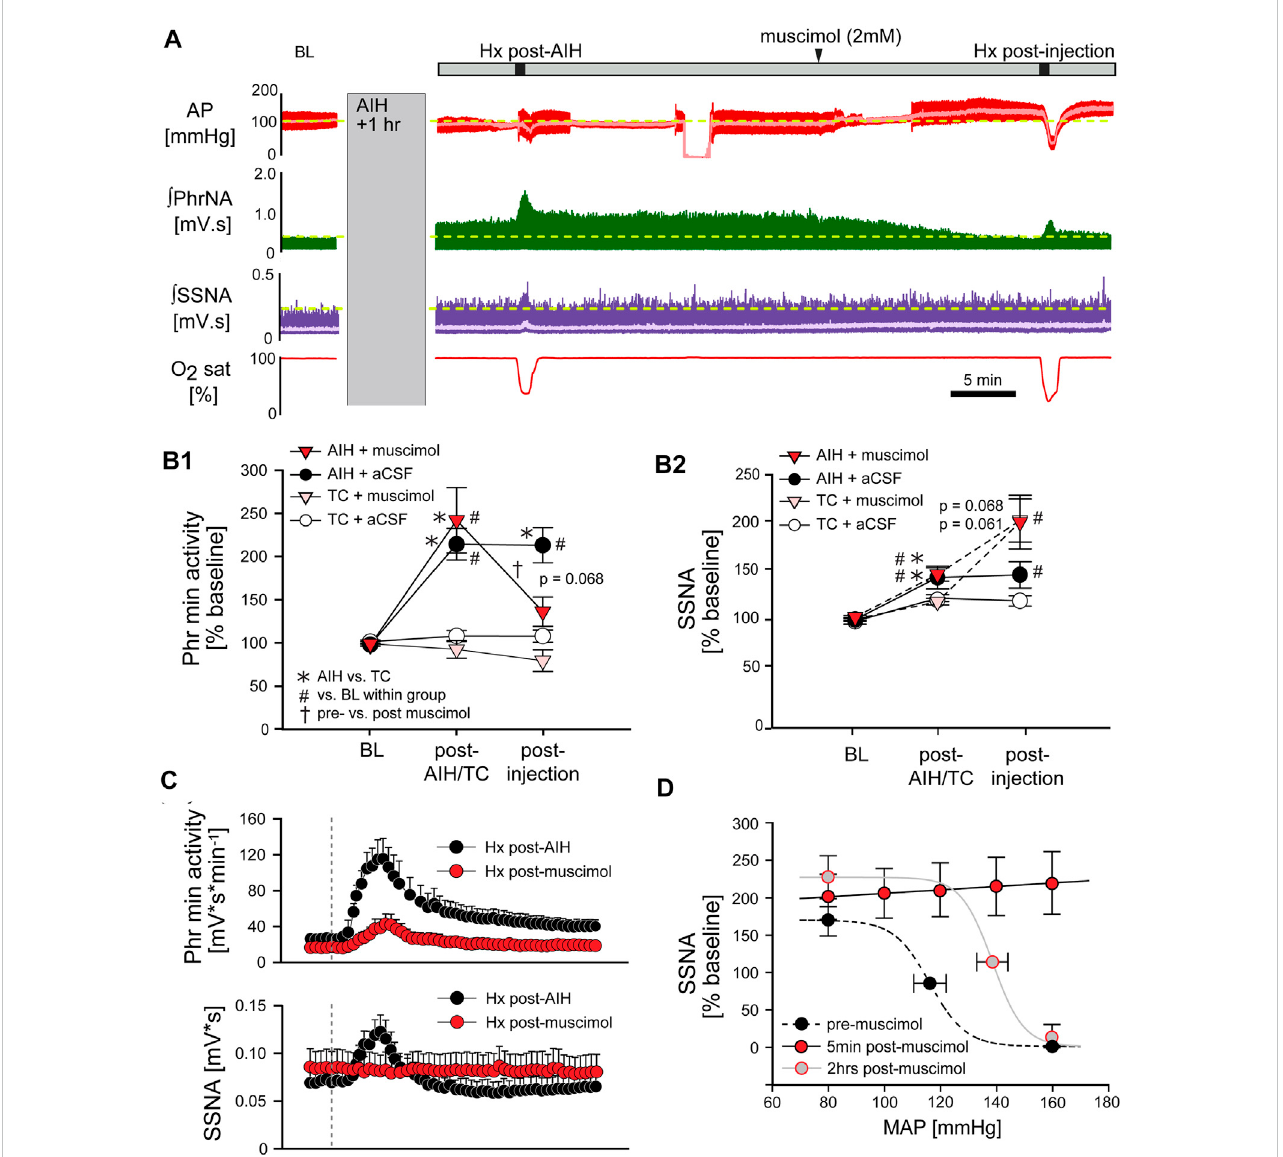
FIGURE 8 InhibitionofnTSactivityfollowingAIHreversespLTF. (A) ExamplerecordingofAP(red,MAPsuperimposedinlightred), ʃ PhrNA(green)and ʃ SSNA(purple, mean in light purple) at baseline (BL), LTF (1 h after AIH), during Hx post-AIH, in response to bilateral nTS injection of muscimol after LTF development and during Hx post-injection of muscimol. (B) Phr min activity (B1) or SSNA (B2) during periods in enriched O 2 in animals injected with muscimol or aCSF after either AIH or TC. Following AIH, Phr min activity and SSNA were signi fi cantly elevated. Subsequent nTS inhibition with muscimol (AIH + muscimol; red triangles, n = 9) reduced Phr min activity whereas control injections of aCSF (AIH + aCSF; black circles, n = 5) had no signi fi cant effect. In TC rats, injections of either muscimol (TC + muscimol; pink triangles, n = 5) or aCSF (TC + aCSF; white circles, n = 3) did not alter Phr min activity. nTS muscimol signi fi cantly increasedSSNAtosimilarlevelsfollowingeitherAIHorTC.Two-wayrepeatedmeasuresANOVA, p ≤ 0.05;*AIHvs.TC,#relativetoBLwithinagroup, † post- AIH vs. post-injection for AIH-muscimol group. (C) Mean responses to hypoxia post-AIH before (black circles) and following injection of muscimol post-AIH (red circles, n = 9). Dashed vertical line marks the onset of the animal breathing 10% O 2 . After injection of muscimol chemore fl ex function was signi fi cantly inhibited (Interaction: Phr min activity, p < 0.001; SSNA, p < 0.001, Two-way repeatedmeasures ANOVA). (D) Barore fl ex function prior to muscimolinjections (black symbols), 5 min after muscimol injections (red symbols, n = 5) and after a recovery period of 2 hrs (grey symbols, n =